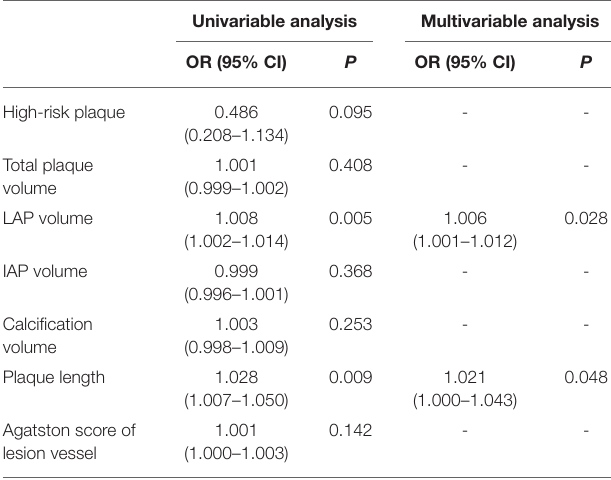
TABLE 4 | Coronary stenosis severity and plaque characteristics according to 1 CT-FFR ( 1 CT-FFR ≥ 0.15).